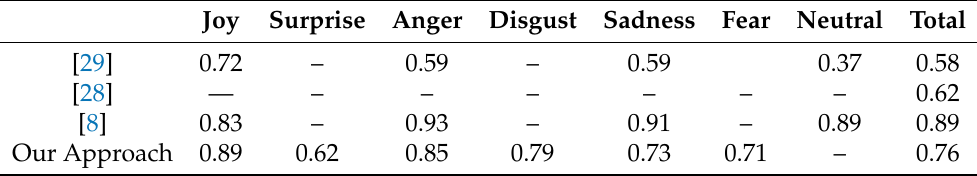
Comparison Per-class emotions accuracy of state-of-the-art methods with semi- natural database.